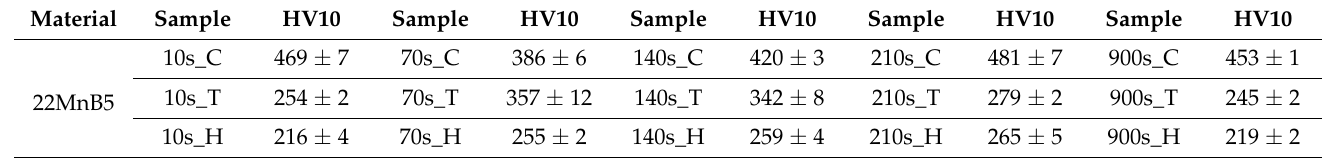
Figure 9. Mechanical properties of 22MnB5 steel (cooled (C) and heated (H) part). Table 3. Hardness of 22MnB5 steel in different parts of the